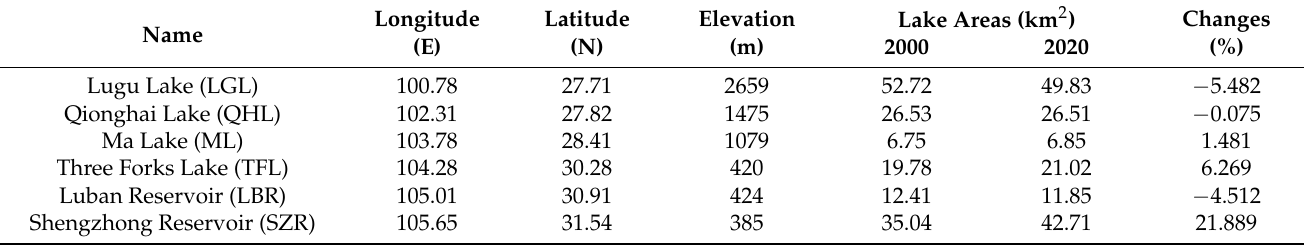
Figure 9. Change in wet season area of selected lakes from 2000 to 2020. ( a ) Lugu Lake; ( b ) Qionghai Lake; ( c ) Ma Lake; ( d ) Three Forks Lake; ( e ) Luban Reservoir; ( f ) Shengzhong Reservoir. Note, the dashed line indicates the multi-year average lake area during the wet season. Table 6. Changes in the area of typical lakes in Sichuan Province from 2000 to 2020 (km 2